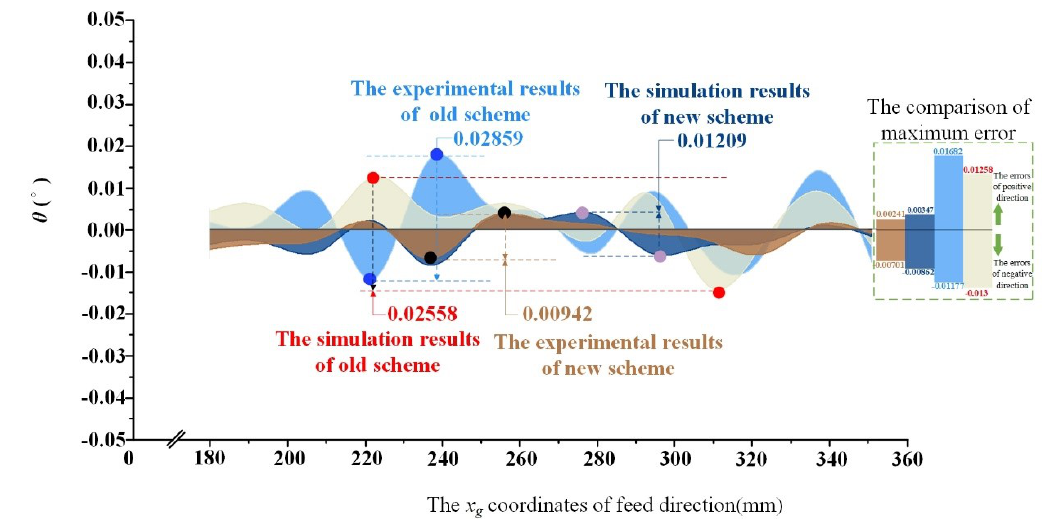
Figure 16. Positional point angular error of the new and old process schemes.